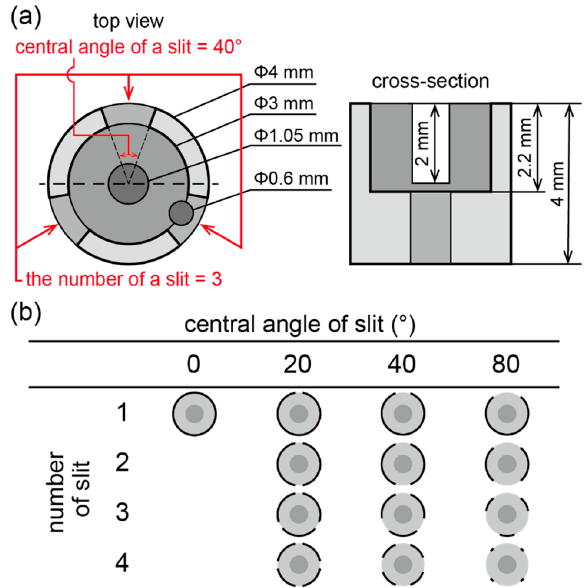
Figure 3. Mini-cup designs for optimization. ( a ) Description of the well dimensions. Note that the 0.6 mm diameter pocket was created to fix the ground electrode at the front side of the well (1 mm in depth). ( b ) Table of central angle and number of the slits of a mini-cup designed for the experiment.